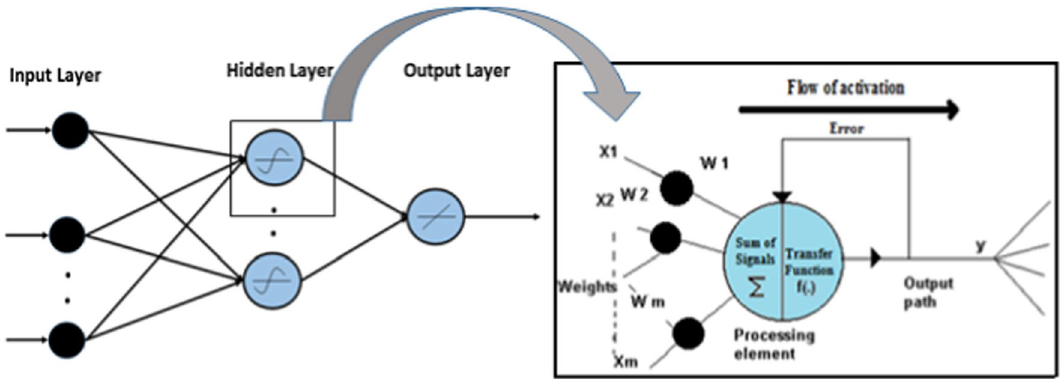
Fig. 2 Example of the MLP model by three layers, viz. input layer, hidden layer, and output layer (Left). A typical processing element with the flow of signals